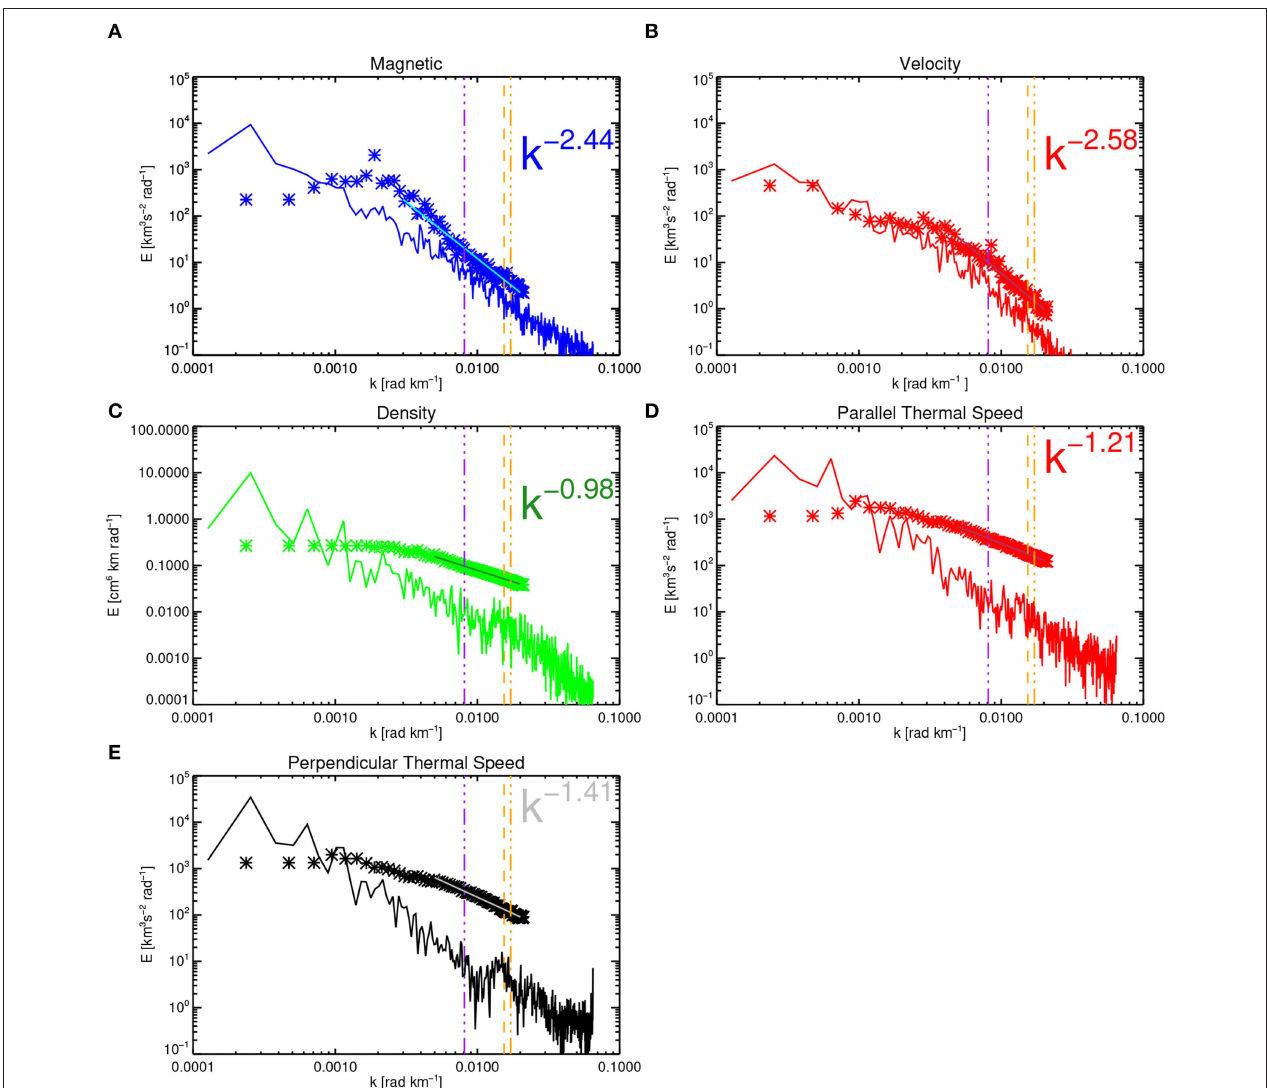
FIGURE 7 | The same as Figures 5 , 6 but for the flow direction. The points denote the values obtained from the multi spacecraft method while the solid lines denote the spacecraft frame spectra with the wave-numbers calculated from assuming Taylor’s hypothesis. The spectral fits to the points also shown by the power law fits and the spectral index is indicated on the